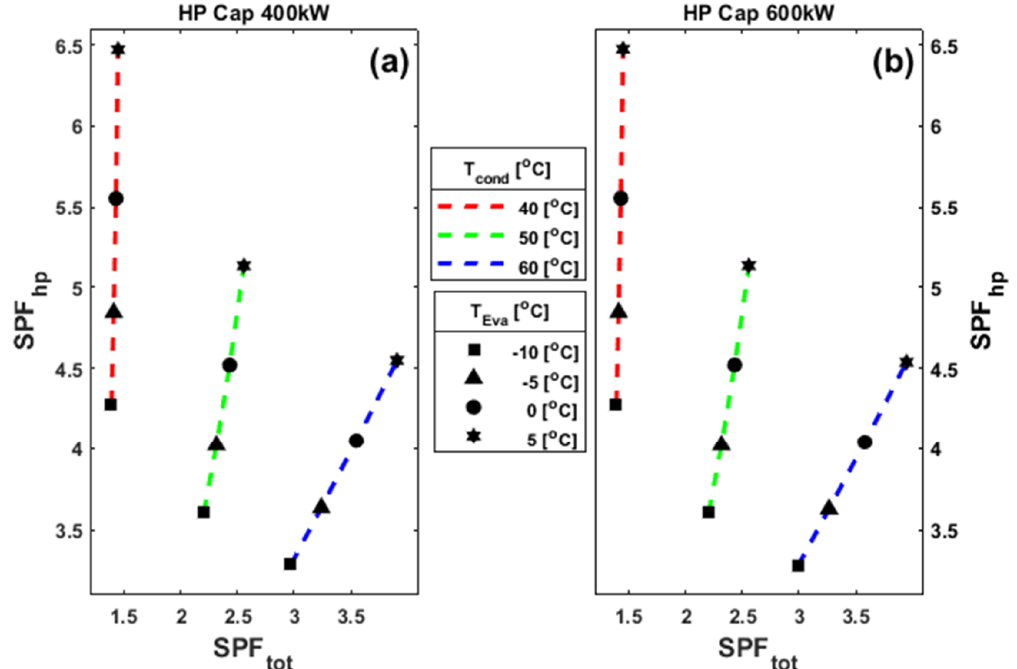
Figure 7. The influence of the evaporator temperature, condenser temperature, and the heat pump capacity: ( a ) 400 kW;